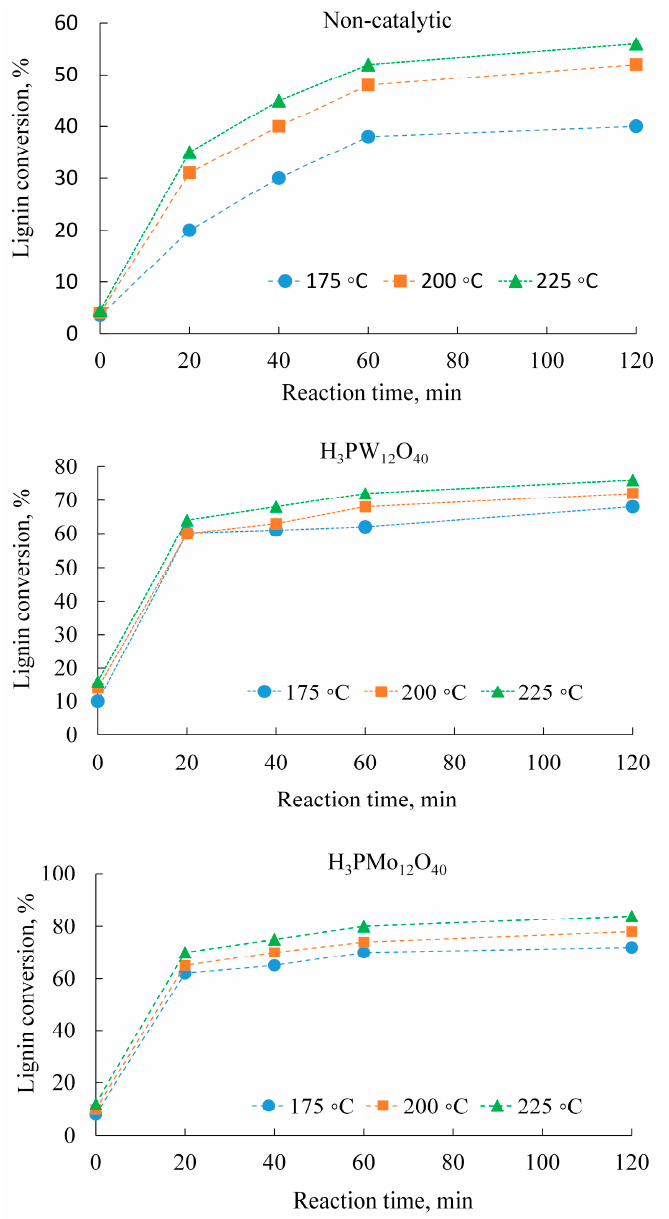
Figure 3. Effects of temperature and reaction time on lignin conversion. In the catalytic experiments, the lignin:catalyst ratio was 2:1 ( w / w ).